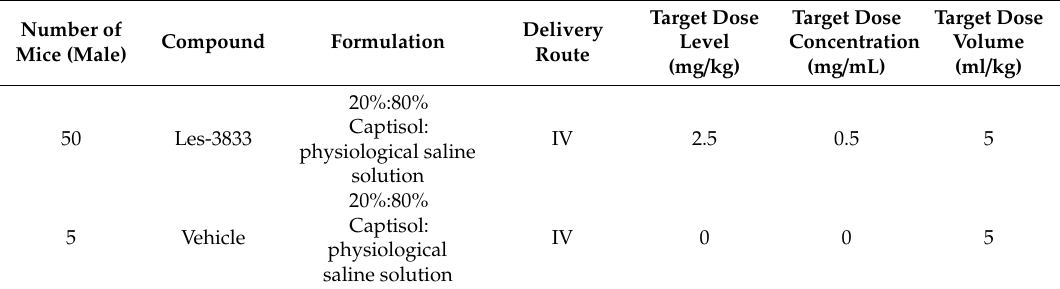
Table 1. Study design and treatment